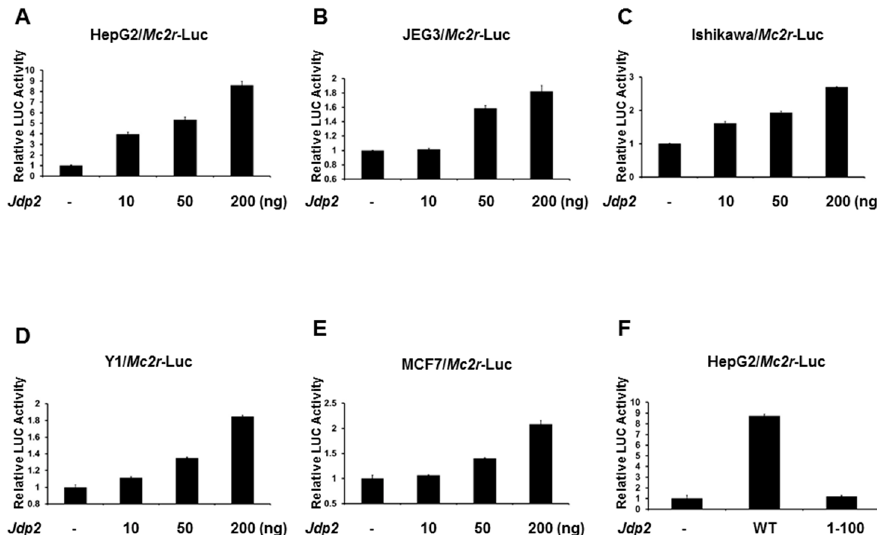
Figure 2. JDP2 activates Mc2r transcription. HepG2 ( A ), JEG3 ( B ), Ishikawa ( C ), Y1 ( D ), and MCF7 ( E ) cells were co-transfected with Mc2r -Luc and different amount of Jdp2 plasmid; ( F ) HepG2 cells were co-transfected with Mc2r -Luc and either wild-type or 1-100 (loss of DNA binding domain) of Jdp2 plasmid. Forty-eight hours after transfection, luciferase activities (LUC) were measured and normalized with Renilla activity. Relative LUC activity (presented as fold activation) was calculated and plotted on a graph. The experiments were conducted three times in triplicate setting. Error bars indicate the standard error. WT: Wild-type.